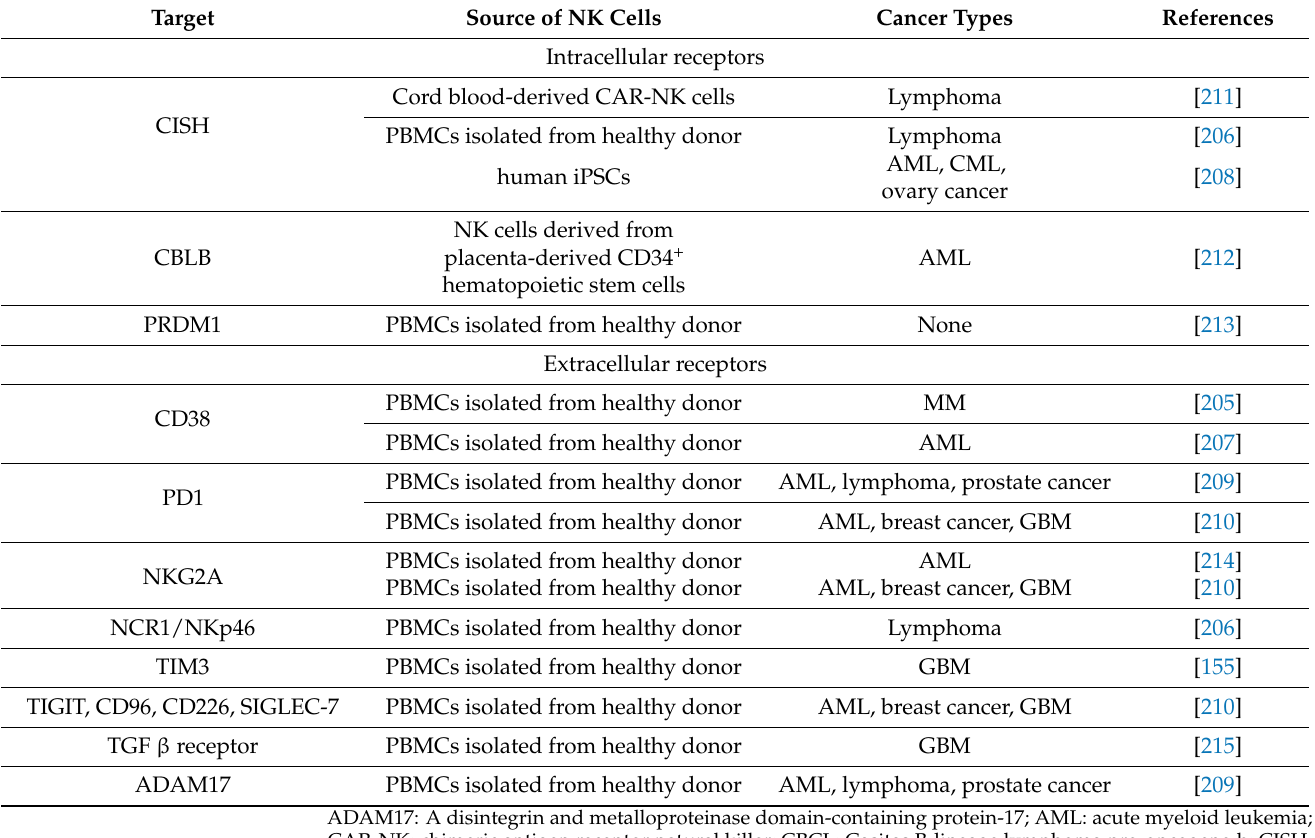
Table 2. CRISPR/Cas9 electroporation genome-editing NK cell-based immunotherapy against all cancers, including